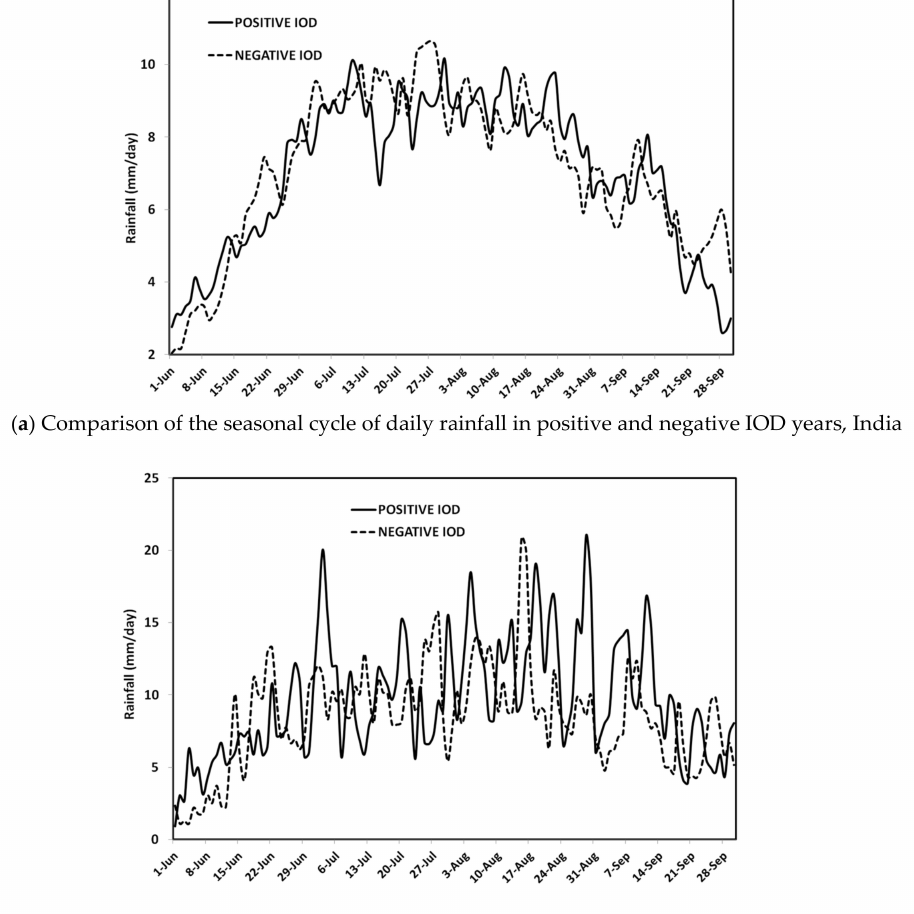
Figure 10. Seasonal cycle of the daily rainfall climatology during the monsoon period (1 June to 30 September) averaged over ( a ) India and ( b ) Odisha composite over the years with positive (thick line) and negative (dotted line) IOD for the period 1 June to 30